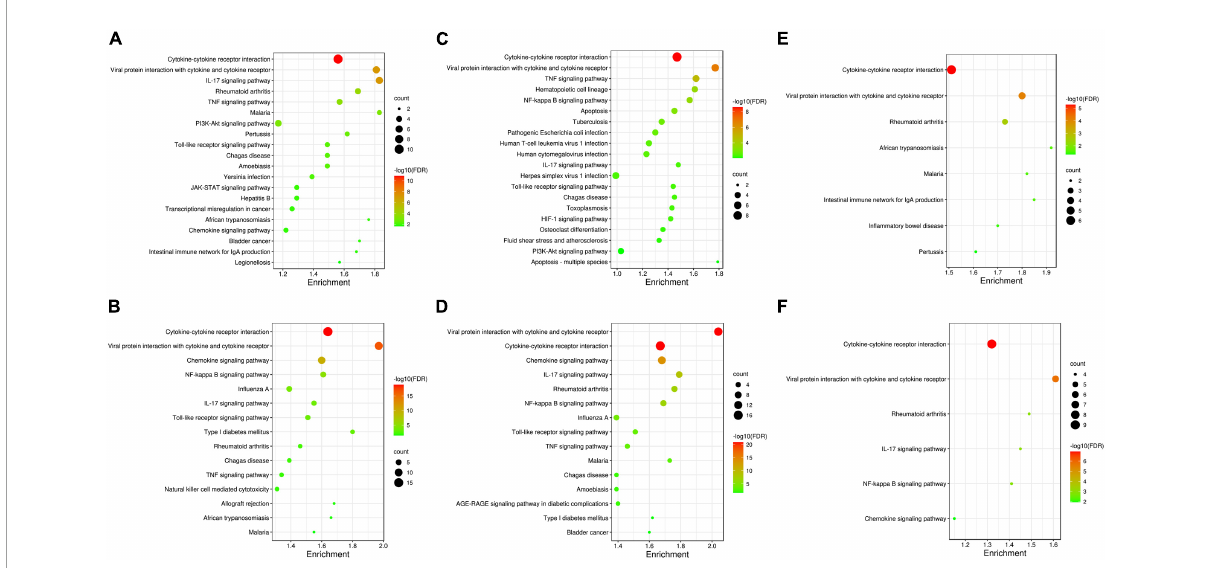
FIGURE3 Kyoto encyclopedia of genes and genomes pathways analysis of altered proteins in three ablation groups. Altered proteins in three groups are all mainly enriched in cytokine–cytokine receptor interaction and viral protein interaction with cytokine and cytokine receptor. (A,B) The top 20 KEGG pathways enriched for the increased proteins and decreased proteins in the cryoballoon ablation group; (C,D) the top 20 KEGG pathways enriched for the increased proteins and decreased proteins in the radiofrequency balloon ablation group; (E,F) the all KEGG pathways enriched for the increased proteins and decreased proteins in the radiofrequency ablation group. The sizes of the bubbles are illustrated from big to small in descending order of the number of potential targets involved in the pathways.